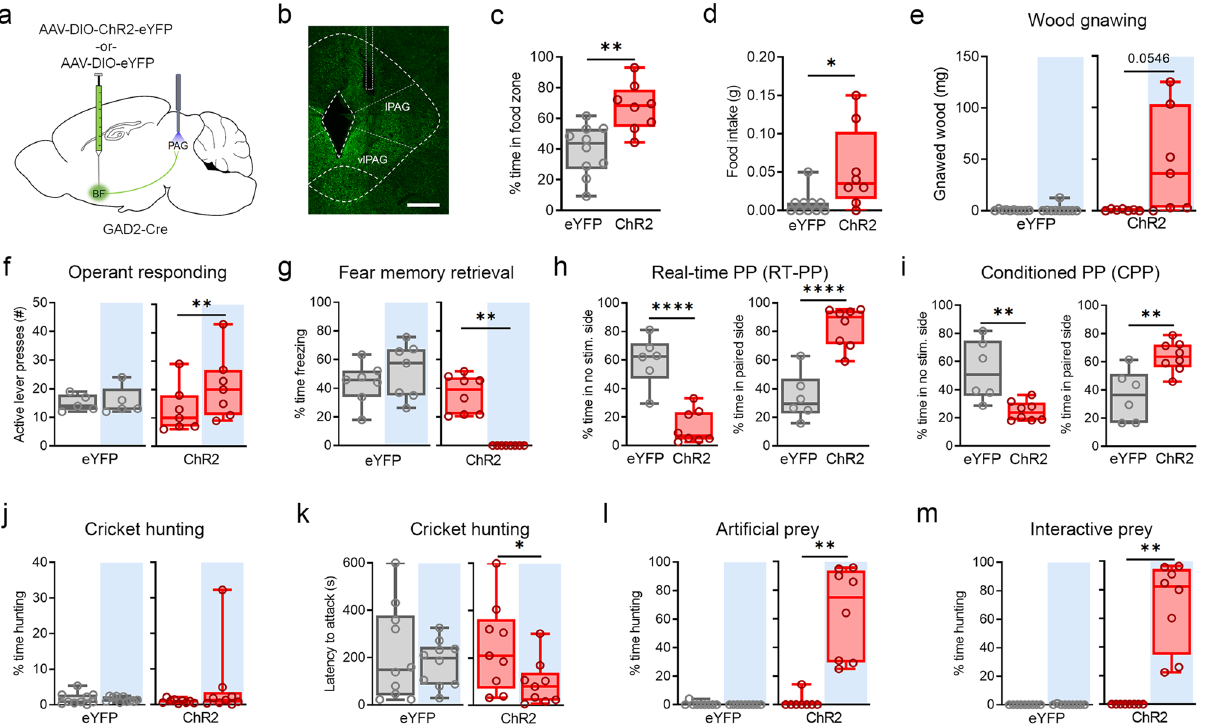
Figure 5. PAG projections mediate BF effects on consumption, reinforcement and predatory hunting. ( a ) Stereotaxic targeting of viral vectors and optogenetic stimulation. ( b ) Confocal image of viral expression and optic fiber placement in BF, 200 µm scale bar . ( c ) Percent time spent in food zone during optic stimulation paired with food. Mann–Whitney test, U = 14, *p < 0.05. ChR2, n = 8; eYFP, n = 10. ( d ) Food intake, ingested mass. Unpaired t-test, t 16 = 3.66. **p < 0.01. ChR2, n = 8; eYFP, n = 10. ( e ) Amount of wood removed due to gnawing during laser ON vs laser OFF epochs. ChR2, paired t-test, t 6 = 2.38. ChR2, n = 7; eYFP, n = 10. ( f ) Active lever presses during test of operant responding for food. ChR2, paired t-test, t 6 = 3.78, *p < 0.05. ChR2, n = 7; eYFP, n = 5. ( g ) CS-evoked freezing during laser ON vs. laser OFF CS trials, following the experimental design in Fig. 2d. ChR2, Wilcoxon signed rank test, W = − 36, **p < 0.01. ChR2, n = 8; eYFP, n = 7. ( h ) Real-time place preference, measured on day 1 during photostimulation. Percent time in unpaired side, unpaired t-test, t 12 = 6.03, ****p < 0.0001. Percent time in stimulation paired side, paired t-test, t 12 = 6.06, ****p < 0.0001. ChR2, n = 8; eYFP, n = 6. ( i ) Conditioned place preference, measured on day 2 in the absence of photostimulation. Percent time in unpaired side, paired t-test, t12 = 3.62, **p < 0.01. Percent time in stimulation paired side, paired t-test, t 12 = 3.62, **p < 0.01. ChR2, n = 8; eYFP, n = 6. ( j ) Percent time spent hunting in the live cricket assay. ChR2, n = 9; eYFP, n = 10. ( k ) Latency to attack in the live cricket assay. ChR2, paired t-test, t 8 = 2.82, *p < 0.05. ChR2, n = 9; eYFP, n = 10. ( l ) Percent time hunting in the artificial prey assay. ChR2, Wilcoxon signed rank test, W = 36, **p < 0.01. ChR2, n = 8; eYFP, n = 9. ( m ) Percent time hunting in the interactive artificial prey assay. ChR2, Wilcoxon signed rank test, W = 36, **p < 0.01. ChR2, n = 8; eYFP, n = 9. Schematic ( a ) was created using BioRender.com and